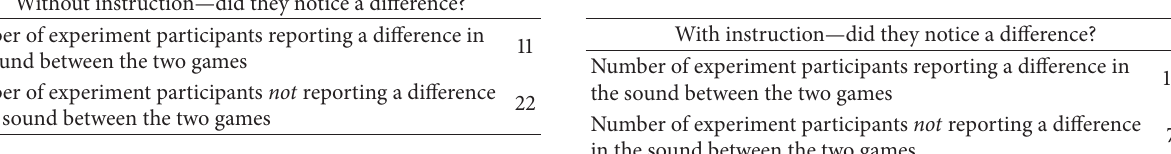
Table 4: Numbers of experiment participants that did not notice the differenceinsoundinthefirstplace,thatsubsequentlydidordidnot notice any difference in sound after being instructed to focus on the sound only.